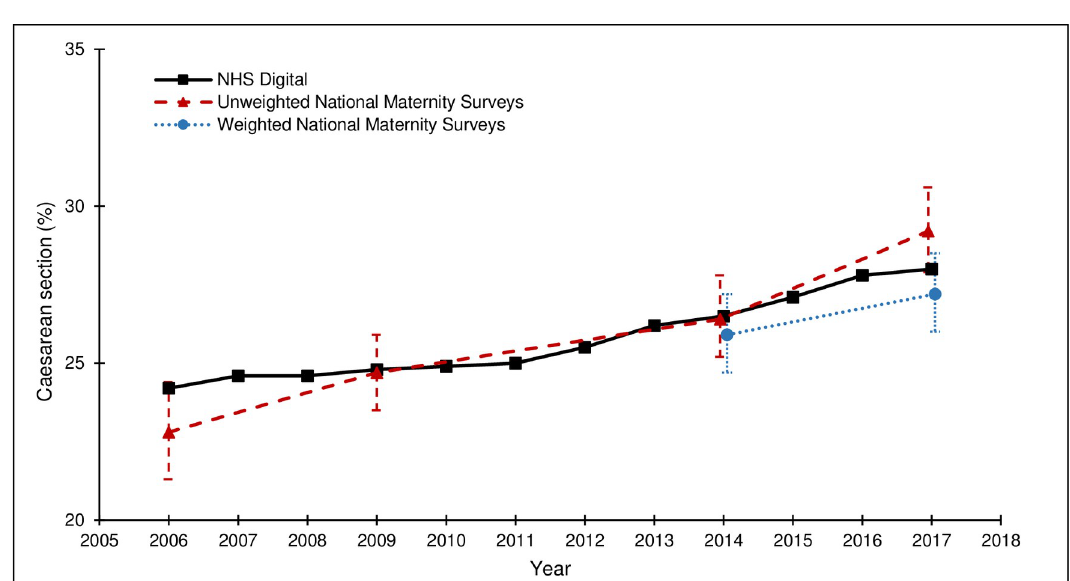
Fig 2. Caesarean section rates from the national maternity surveys^ and NHS Digital. ^ Women gave birth in 2009, survey conducted in 2010; Women gave birth in 2017, survey conducted in 2018.